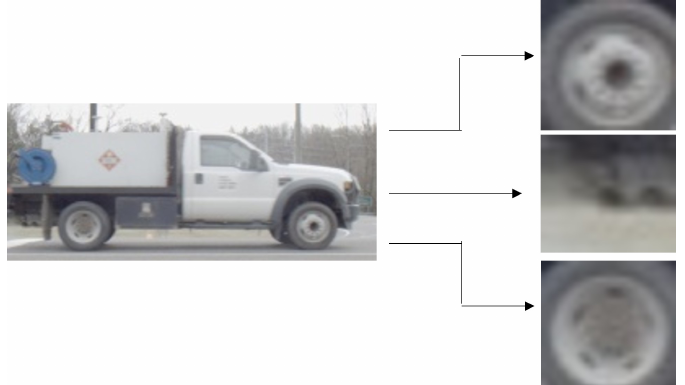
Figure 4. A Vehicle image and its detected wheels before wheel selection.